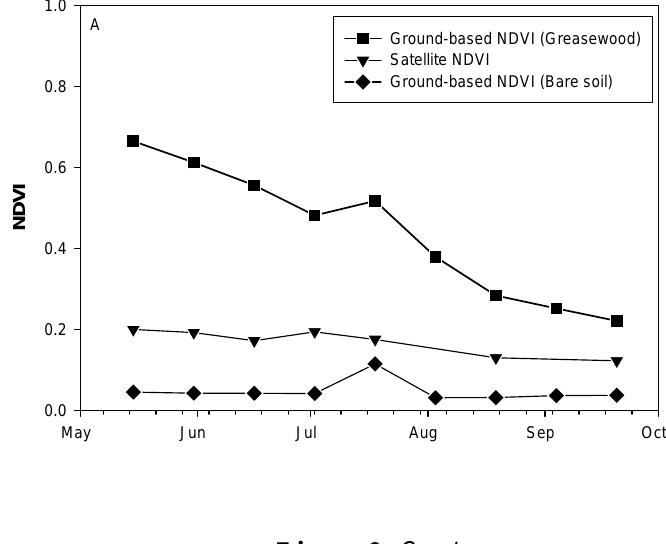
Figure 9. Comparison of ground-based NDVI values and Landsat-NDVI acquired during satellite overpasses. Average midday ground-based NDVI values are for (A): greasewood and bare soil (closed symbols) from the Snake Valley 1 site and for (B): greasewood, sagebrush, rabbitbrush and bare soil (open symbols) from the Spring Valley 1 site. Landsat-NDVI values (closed inverted triangle) are from (A): Snake Valley 1 site and (open inverted triangle) (B): Spring Valley 1